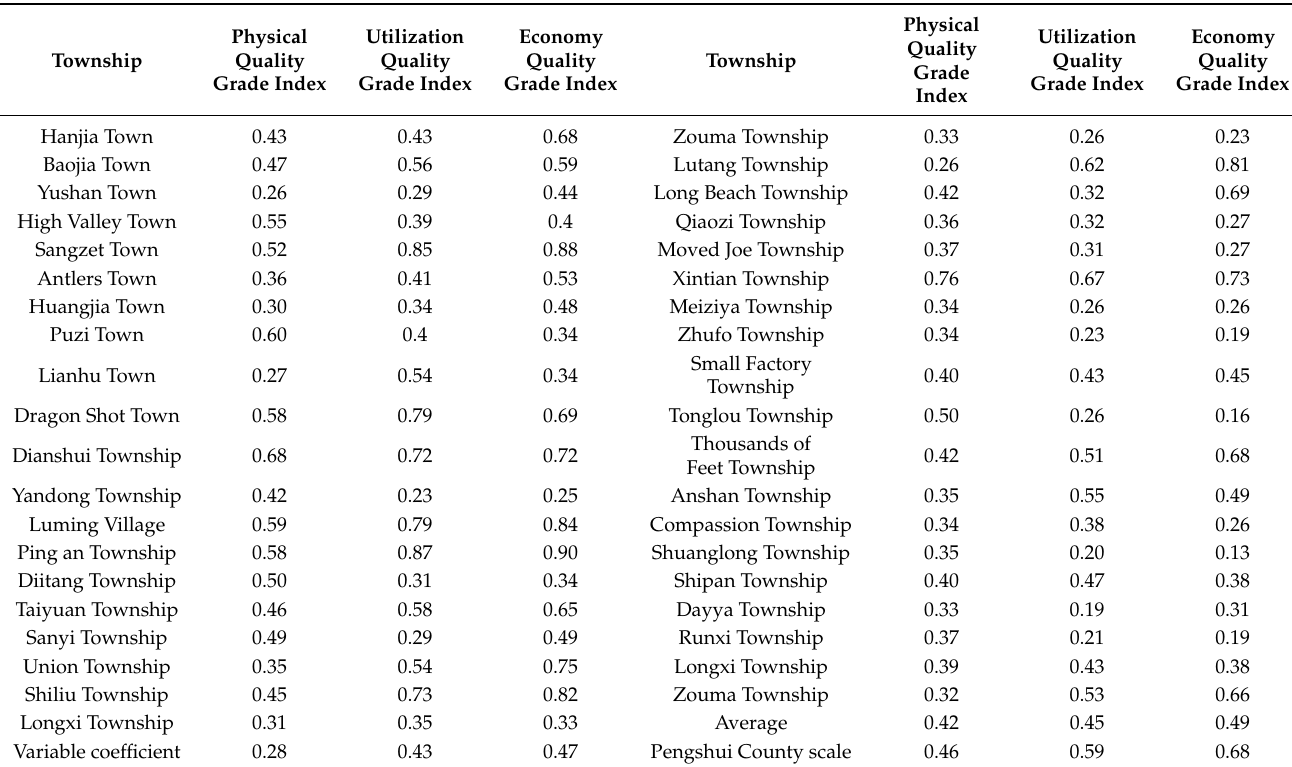
Table 4. Moran’s I value of global spatial auto-correlation analysis of township cultivated land quality in Pengshui